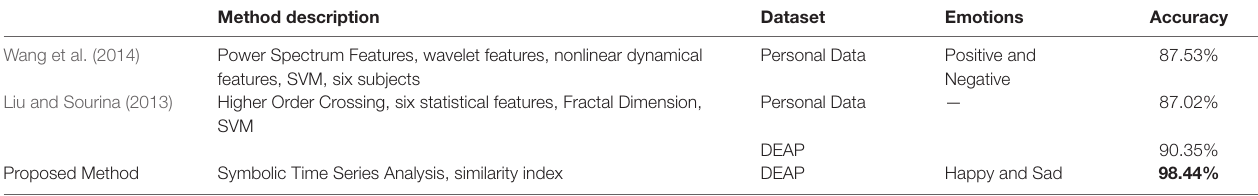
TABLE 1 | Comparison of different studies for emotion recognition using EEG—two groups of emotions.